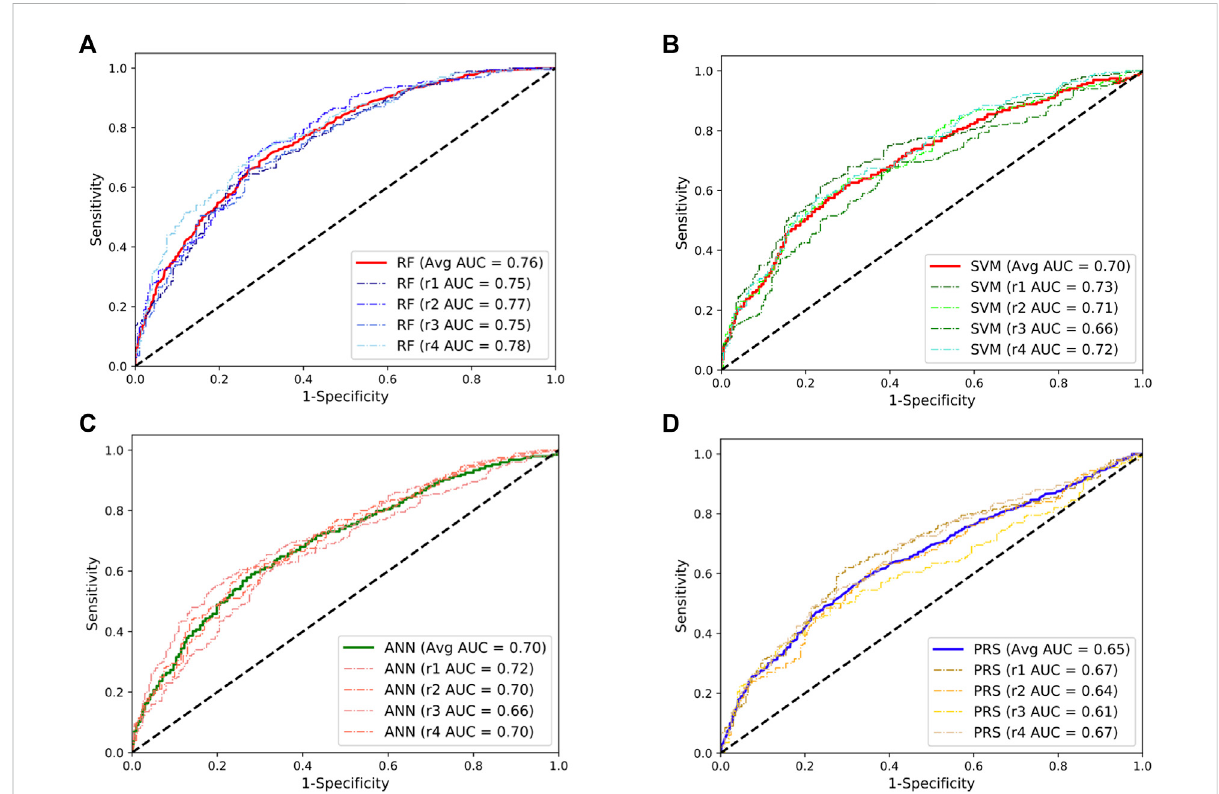
FIGURE 2 Performances of the random forests (RF; (A) ), support vector machine (SVM; (B) ), arti fi cial neural network (ANN; (C) ), and the lassosum-based polygenic risk scoring (PRS) model (D) in predicting the development of SLE in European population. The dashed line indicates the performance for each repeat. The solid lines indicate the averaged performance among the four